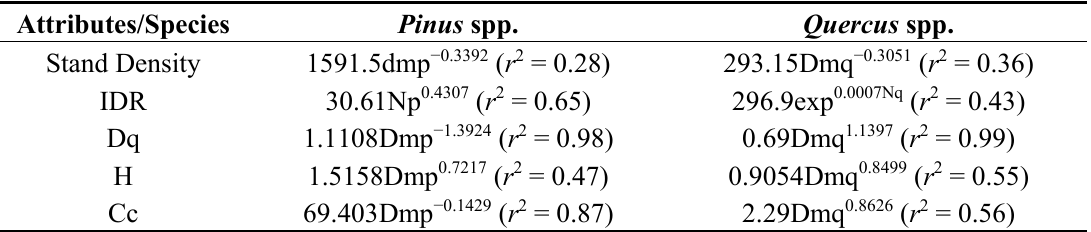
Table 6. Empirical prediction equations that form the core of the stand-class growth and yield model for pines and oaks.